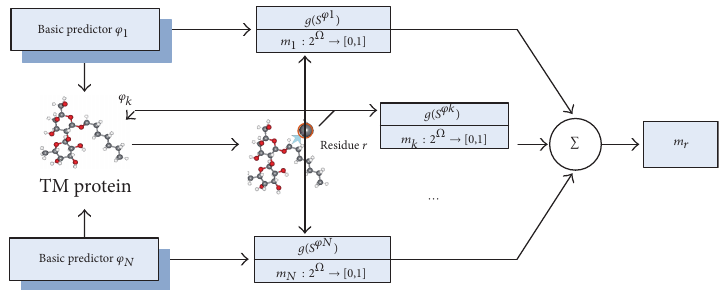
F 2: e combination of multiple predictors.